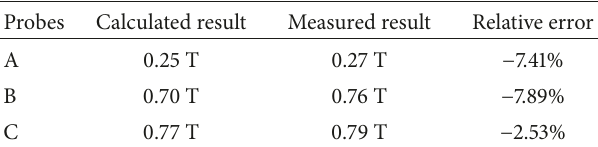
Table 3: Comparison between the calculated and measured value of magnetic